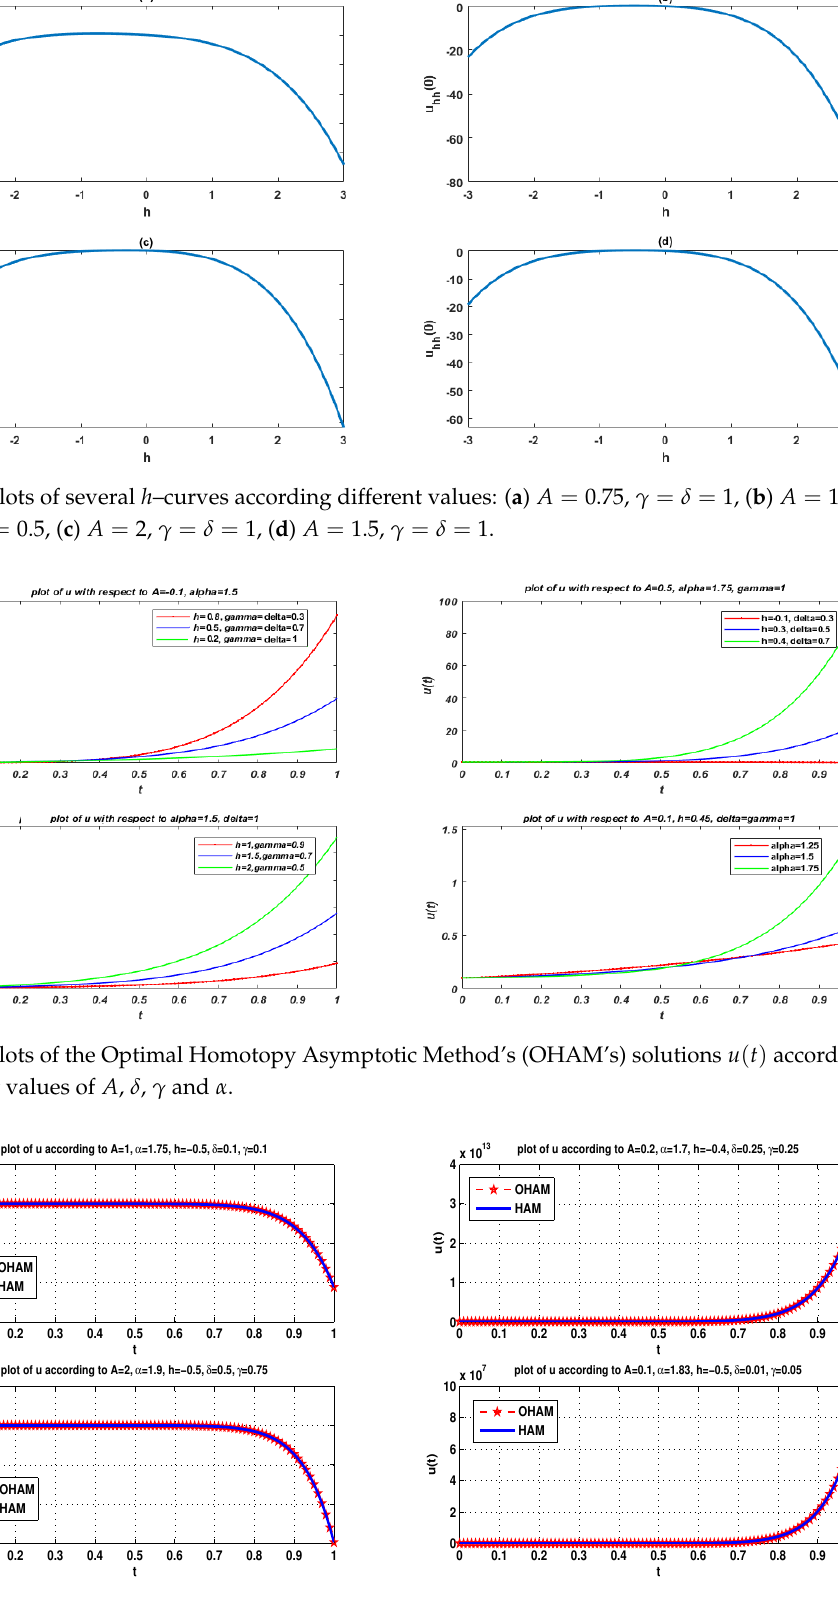
Figure 3. Graphical comparisons between the OHAM and Homotopy Analysis Method (HAM) for different values of A , λ , α and h